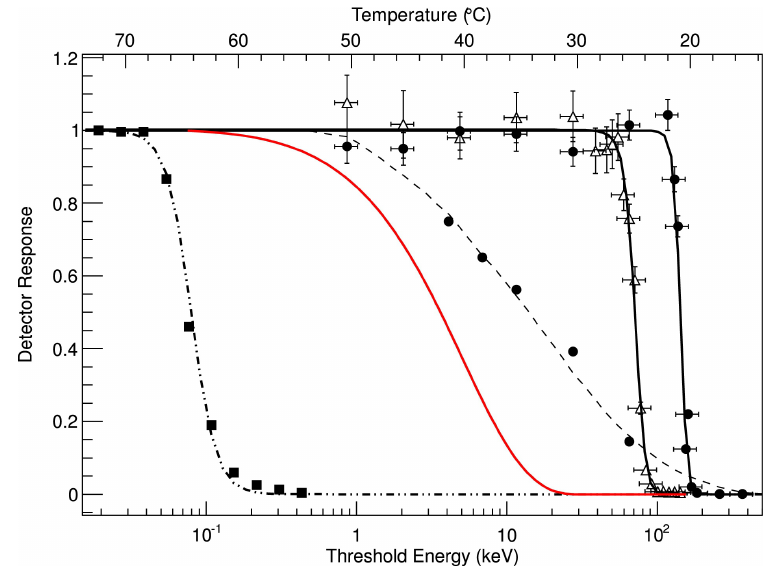
F . From left 4 10